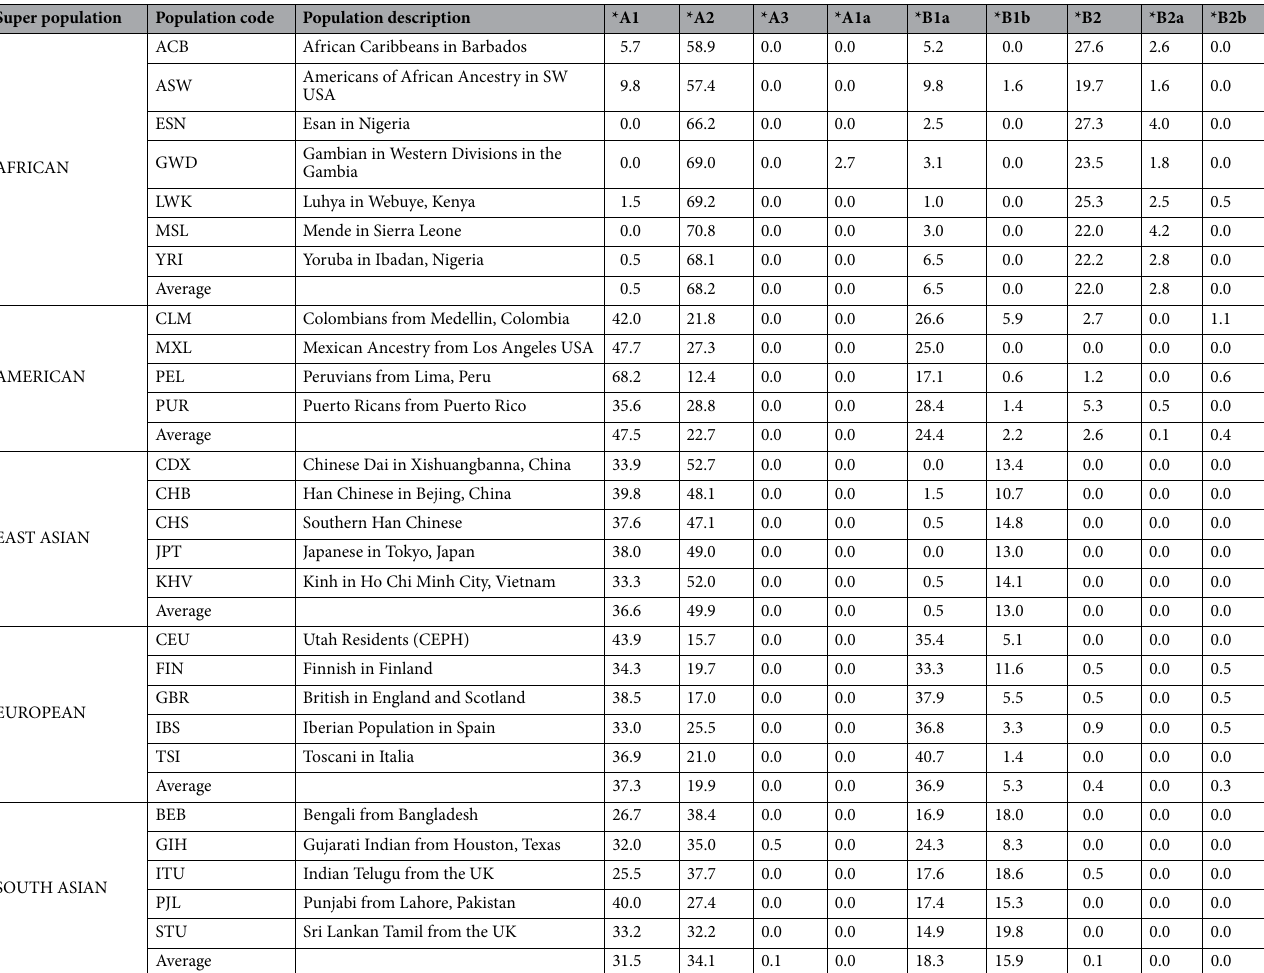
Table 2. GSTA1 Haplotype percentage frequencies for each sub-population and super-population. The frequencies are based on the following numbers: Africa, N = 660; America, N = 347; East Asia, N =